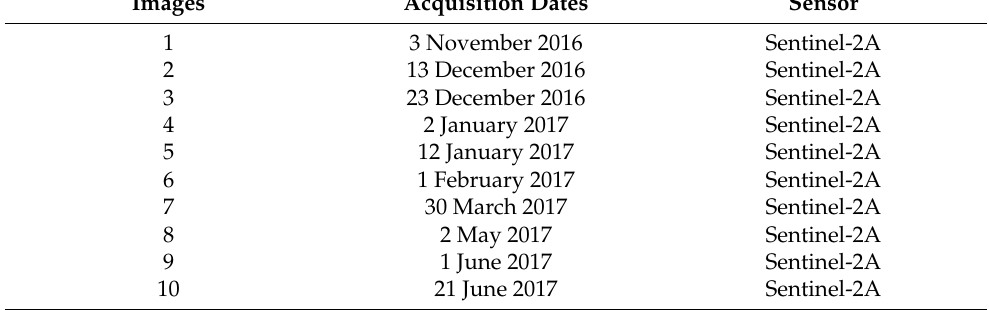
Table 1. Sentinel-2A image acquisition dates. Figure 2. Variation of ET0 and average daily temperature (Tavg) during the 2016/2017 agricultural season.